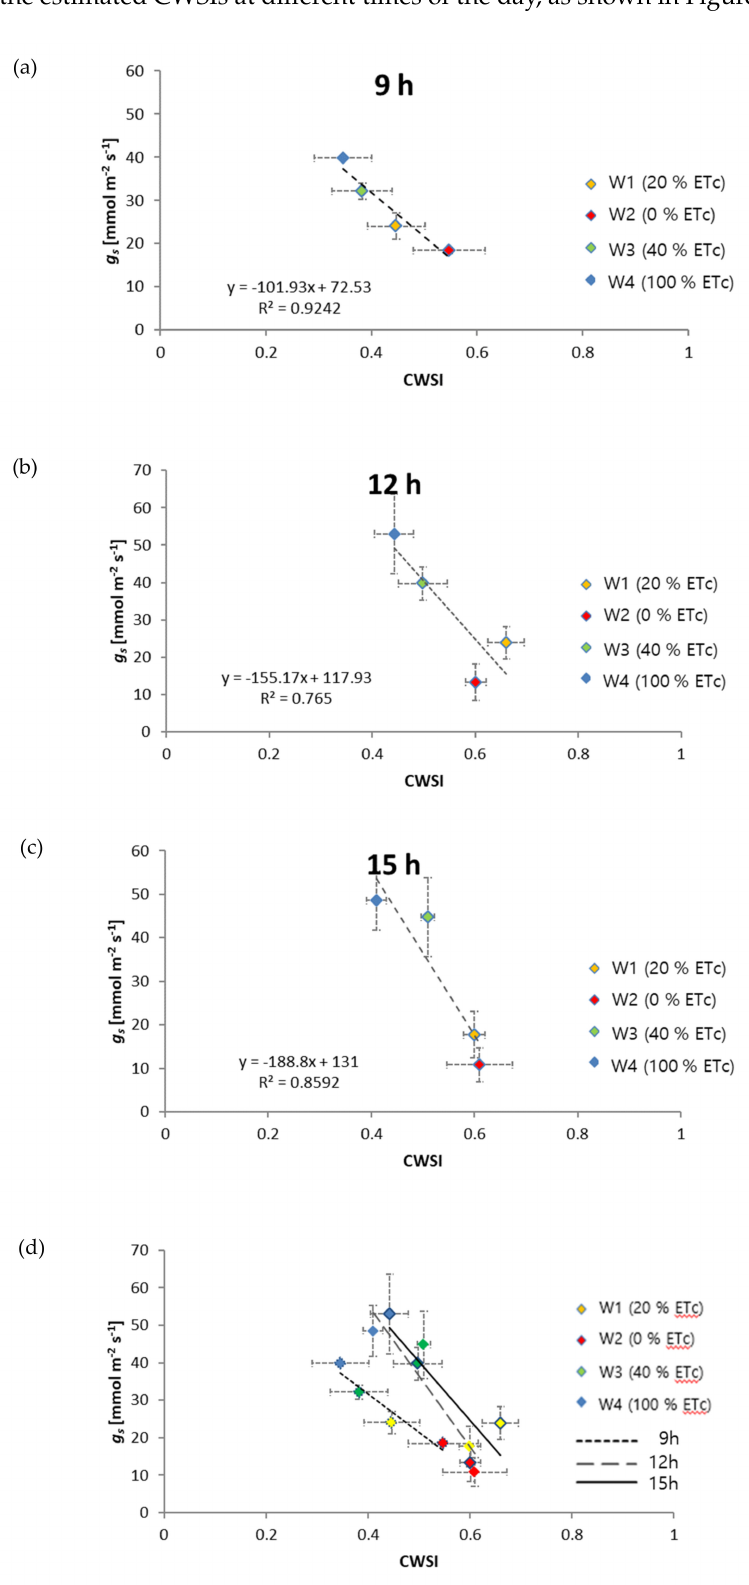
Figure 6. Relationships between stomatal conductance ( g s ) and adaptive CWSI acquired at: ( a ) 9 h; ( b ) 12 h; ( c ) 15 h; and ( d ) all three